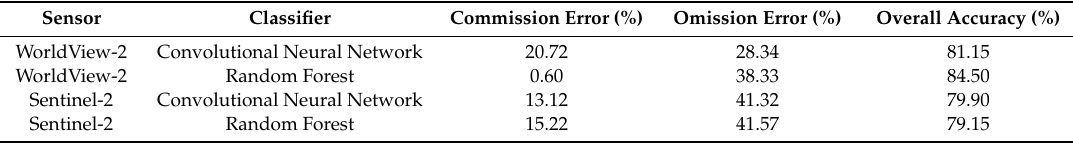
Table 4. Study Site 2 results displaying the commission and omission errors of the shoals class and the overall accuracy for the three shoals, deep water, and land classes.